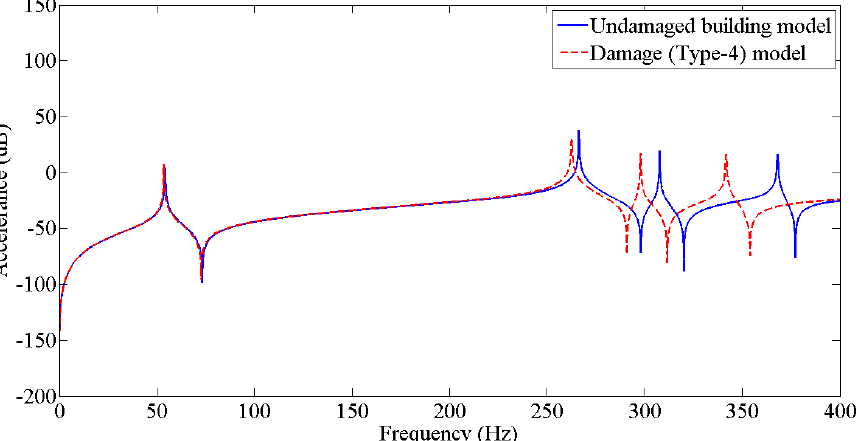
Figure 9. Prediction of structural dynamic behavior of building model under undamaged and damaged (Type − 4) conditions through FRFs.